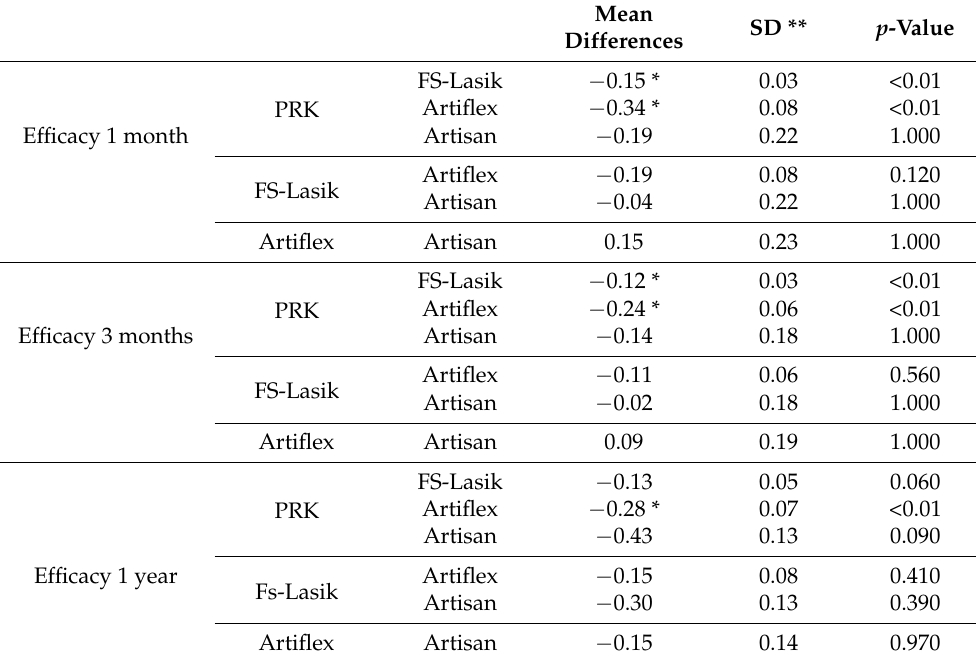
Table 2. Comparison between surgeries techniques’ efficacy in the follow-up